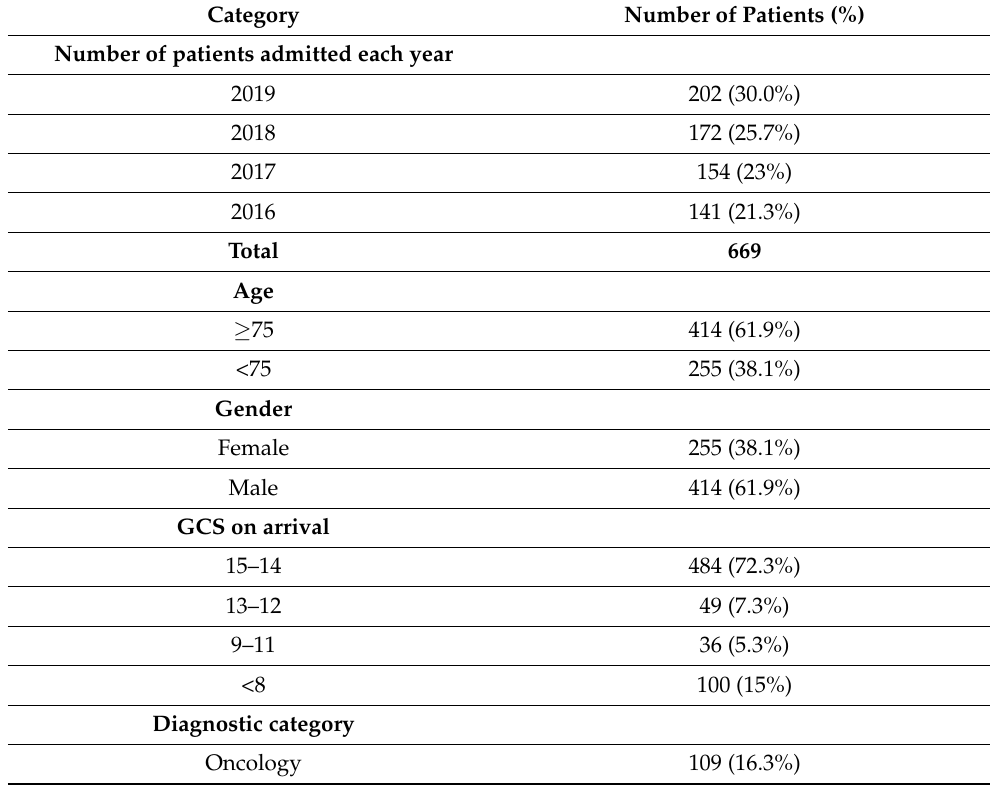
Table 1. Demographic characteristics of the geriatric